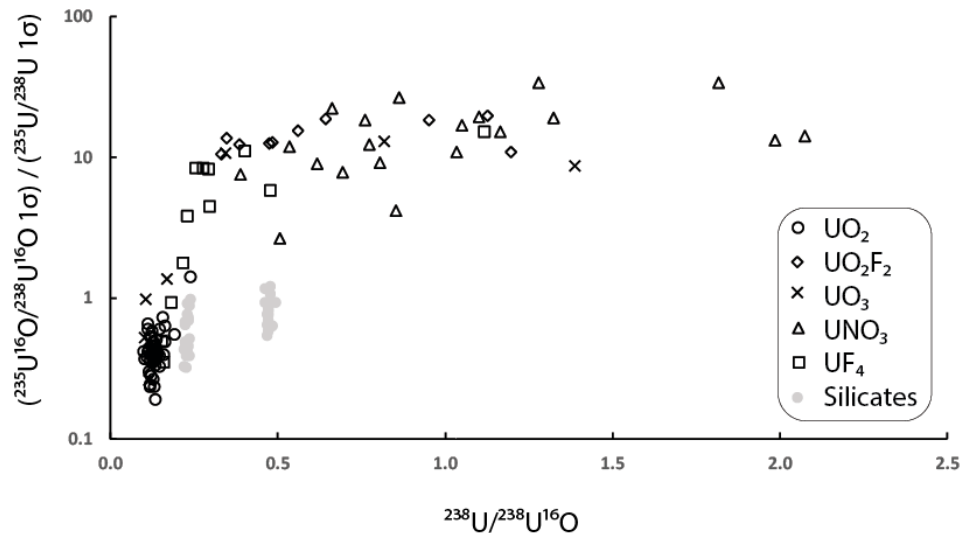
Figure 12. Plot of each analysis’s uncertainty in the 235 U 16 O / 238 U 16 O ratio relative to uncertainty in the 235 U / 238 U ratio as a function of that analyses of average 238 U / 238 U 16 O ratio for the various uranium compounds and silicate materials examined in this study. Note the progression toward poorer precision of the 235 U 16 O / 238 U 16 O relative to the 235 U / 238 U ratio as the 238 U / 238 U 16 O ratio increases.